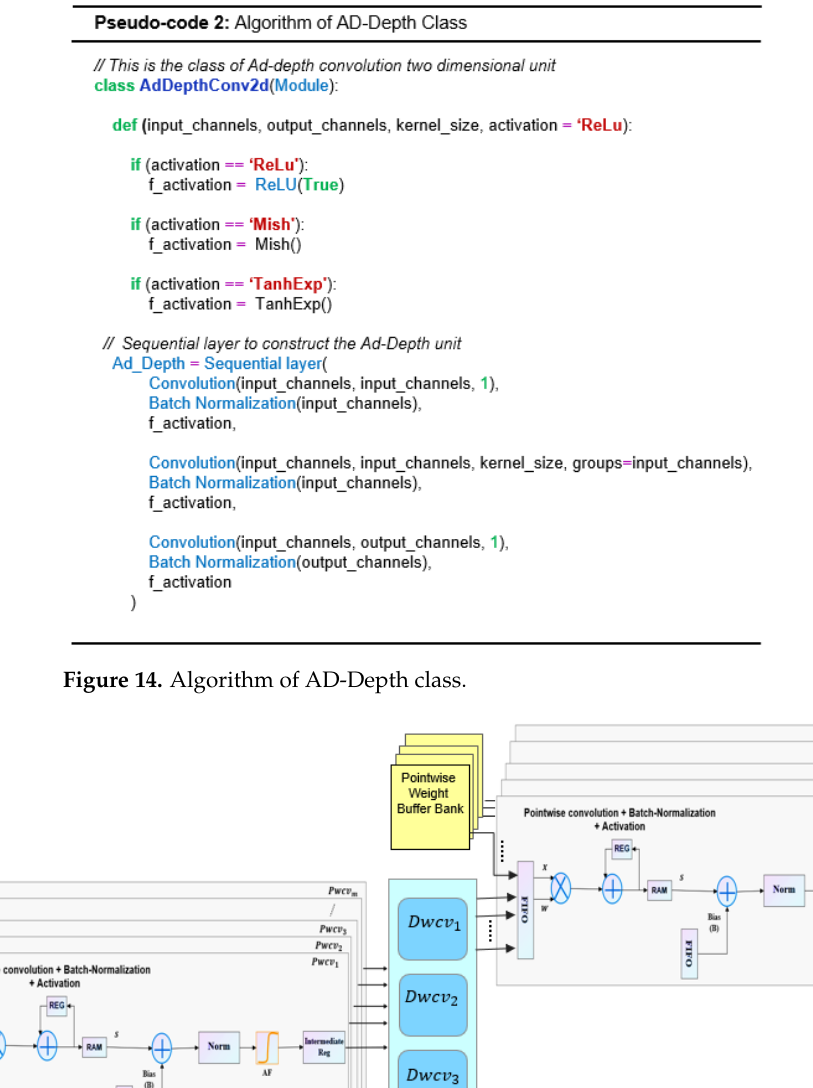
Figure 13. Hardware architecture of the Dwcv unit.